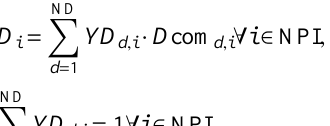
Fig. 1, the network is gravity fed by a single reservoir with a fixed level of 55 m and comprises 33 pipes and 16